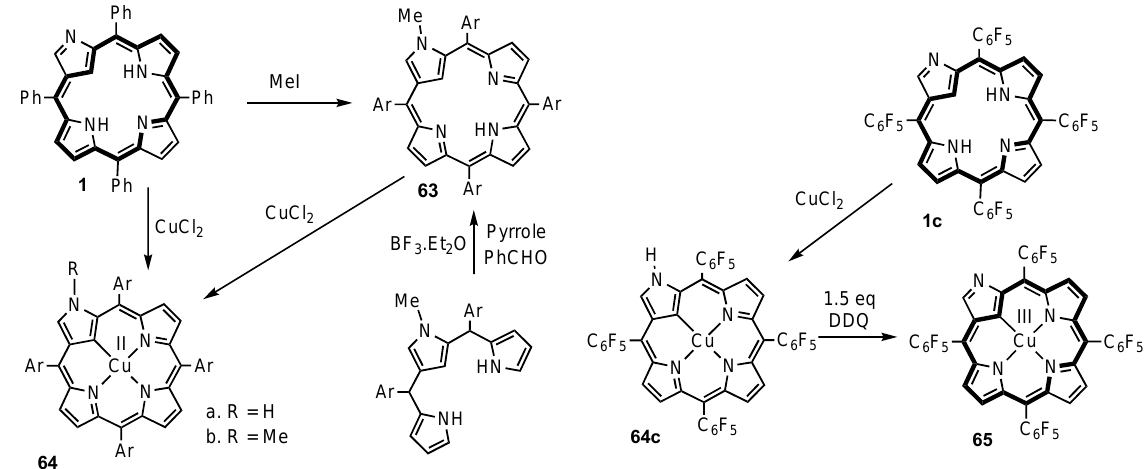
Scheme 13. Copper complexes of N-confused porphyrins.